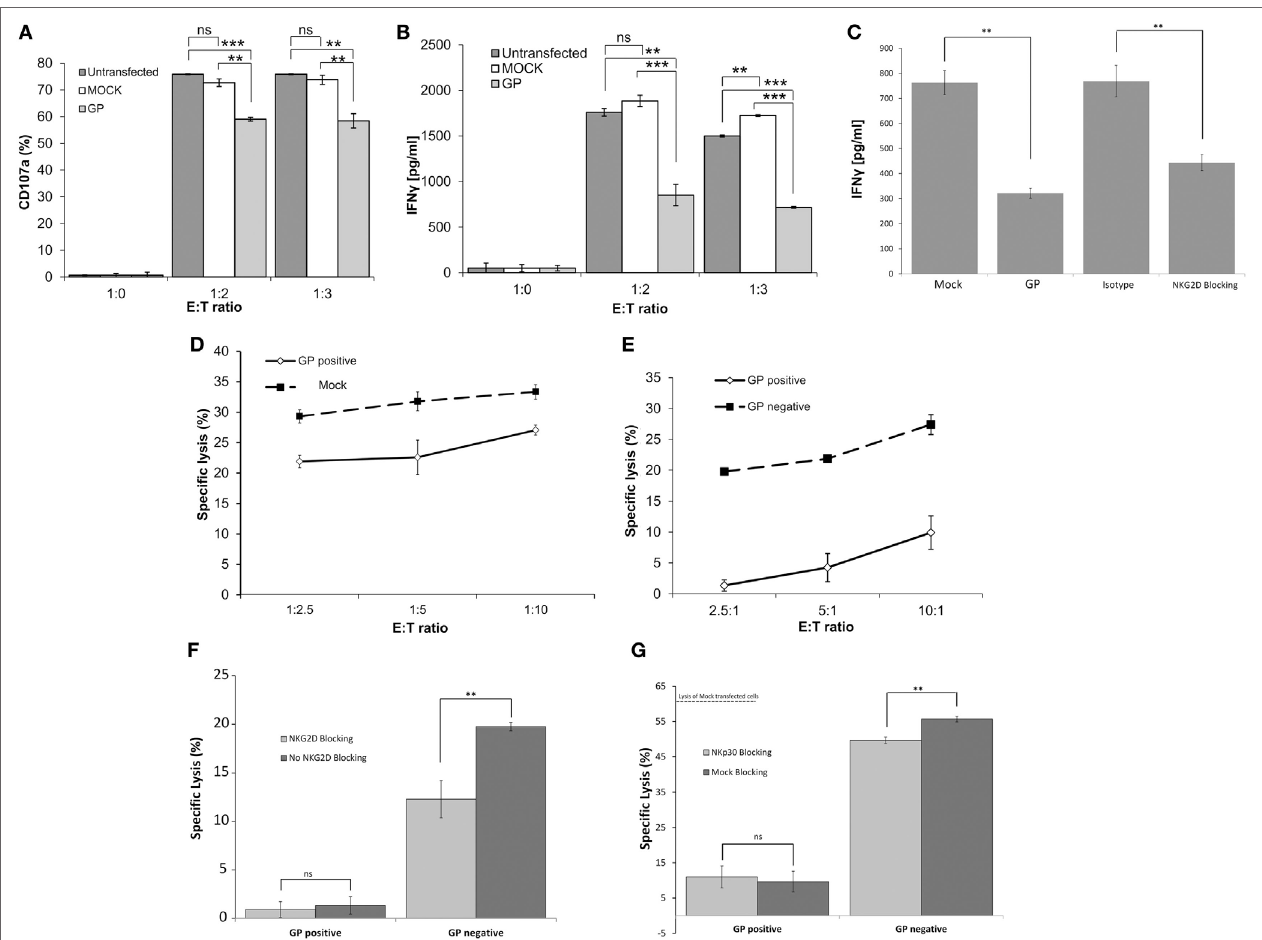
FigUre 5 | Sudan virus (SUDV)-GP-induced disruption of surface antigens downmodulates pNK activation. HEK293T cells were either SUDV-GP transfected, mock transfected, or left untransfected and cocultured with pNK cells in the presence of 25 U/ml rhIL2. Effector cells, target cells, and growth media were sampled and assayed for natural killer cell activation markers. (a) Target and effector cells were cocultured at the ratios specified in the figure for 6 h. Cells were then harvested and analyzed for degranulation by flow cytometry. Dead cells were excluded by 7-aminoactinomycin D (7AAD); pNK cells were then gated by staining for CD16 and co-stained for degranulation by staining for CD107a. (B) Target and effector cells were cocultured at the specified ratios for 18 h. The culture medium was sampled, and IFN γ was quantified using an ELISA assay. (c) Target cells were either SUDV-GP transfected or Mock-transfected; Mock-transfected cells were then incubated with anti-NKG2D or incubated with isotype control and cocultured with effector cells for 18 h. The culture medium was sampled, and IFN γ was quantified using an ELISA assay. (D) Carboxyfluorescein succinimidyl ester (CFSE)-stained Mock- or GP-transfected cells and unstained effector cells were cocultured at the specified ratios for 6 h. Cells were then harvested and analyzed for specific lysis by assessing the viability CFSE + cells using 7AAD. (e) CFSE- stained GP-transfected target cells and unstained effector cells were cocultured at the specified ratios for 6 h. Cells were then harvested and analyzed for specific lysis by flow cytometry. Cells were stained for SUDV-GP with biotinylated 3C10 antibody followed by APC-conjugated streptavidin. CFSE + GP + and CFSE + GP − cells were gated and analyzed for viability using 7AAD. (F) Effect of anti-NKG2D blocking on specific lysis of GP-negative and GP-positive HEK293T cells by pNK cells (E:T 3:1). (g) Effect of blocking with anti-NKp30 versus incubation with isotype control on specific lysis of GP-negative and GP-positive HEK293T cells by pNK cells (E:T 3:1). Results are from one representative experiment of four (a,B,D,e) and two (c,F) performed. Values represent means of triplicates. Bars, ± SD.